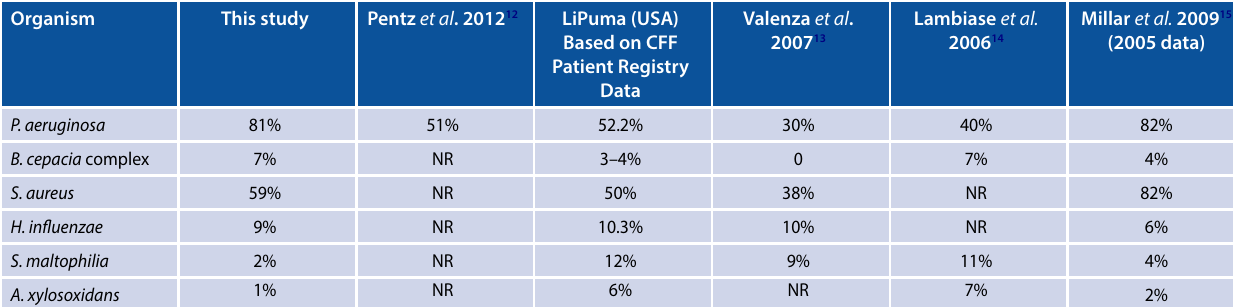
NR: Not Reported. CFF: Cystic Fibrosis